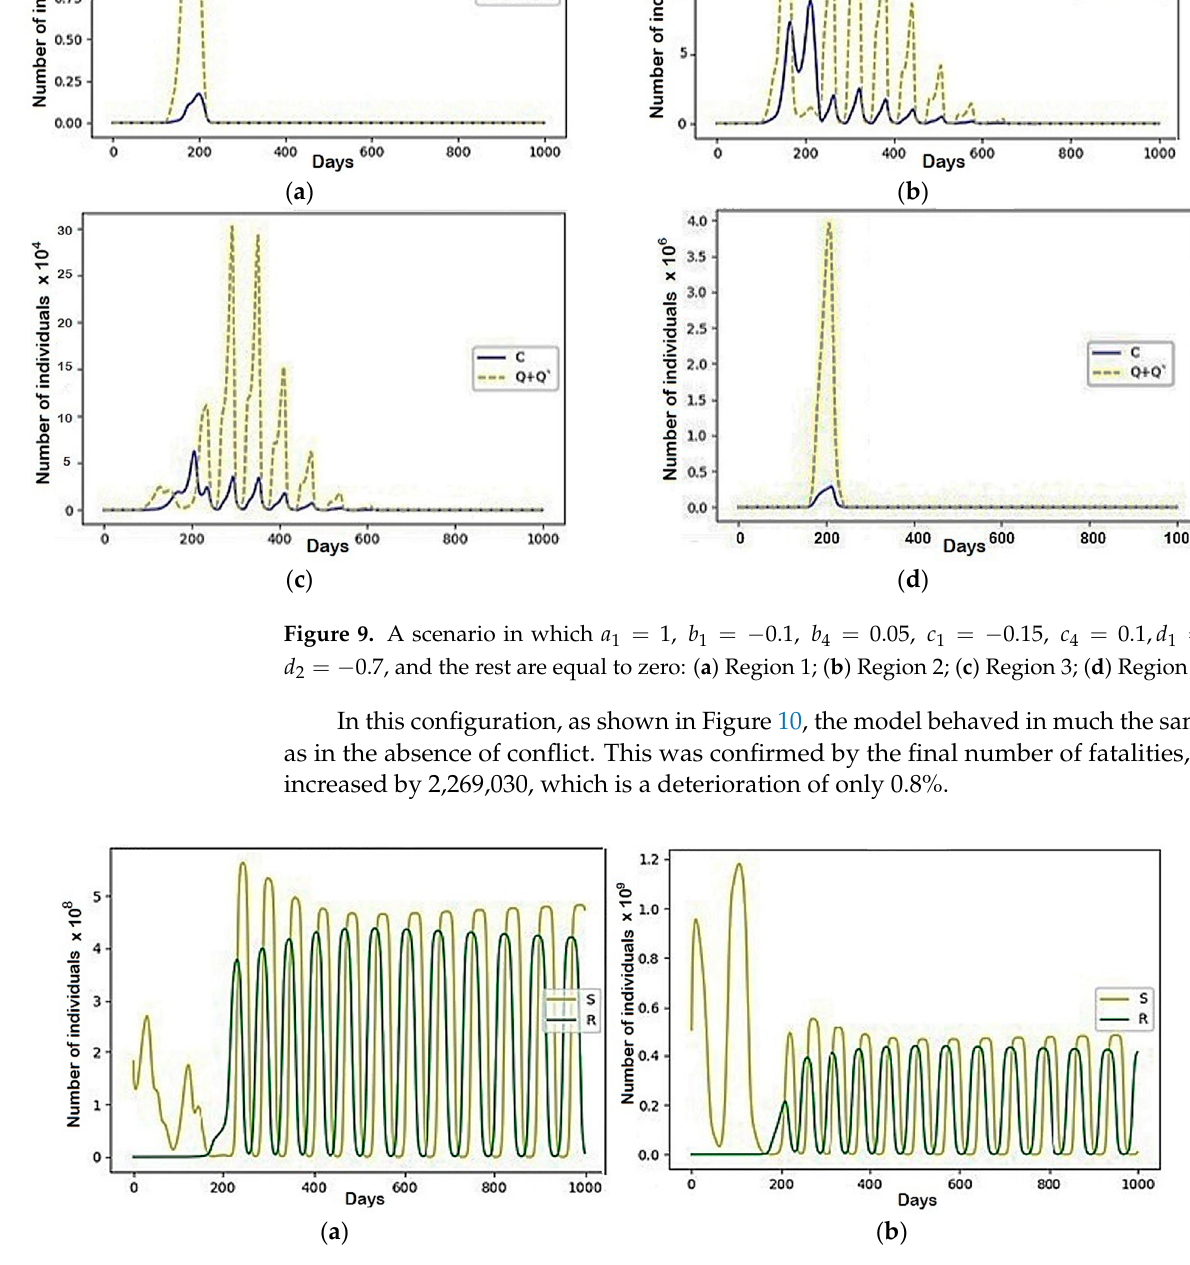
Figure 10. The modeling results describing the recovered (R) and the susceptible (S) group, where 𝑎 (cid:2869) = 1, 𝑏 (cid:2869) = −0.1,𝑏 (cid:2872) = 0.05,𝑐 (cid:2869) = −0.15,𝑐 (cid:2872) = 0.1, 𝑑 (cid:2869) = −0.3, 𝑑 (cid:2870) = −0.7 , the rest are equal to zero: ( a ) Region 1; ( b ) Region